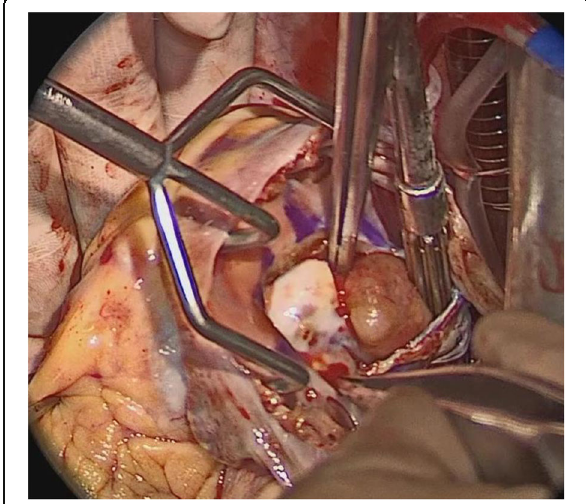
Fig. 2 Intraoperative image. Giant tumor adhered to the free wall was deployed to the right atrium space by manual compression of the outside of RV wall via the tricuspid